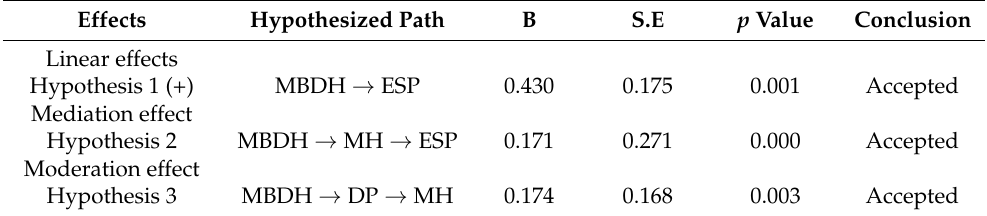
Table 7. Hypothesis Testing Outcomes.